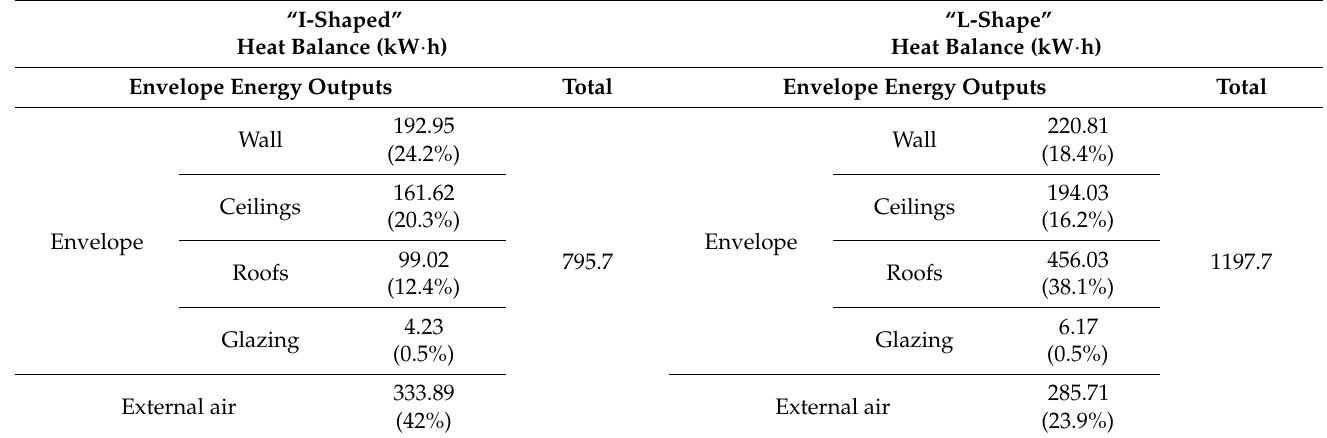
Table 12. The energy consumption after renewal.